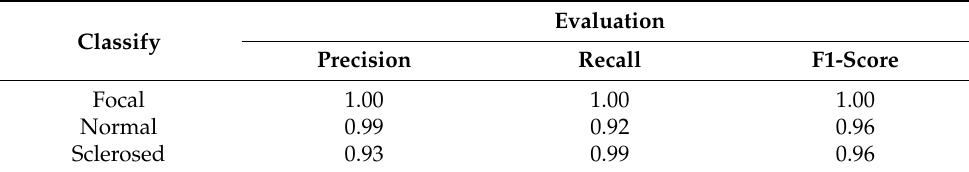
Table 7. Classification of the cross model.